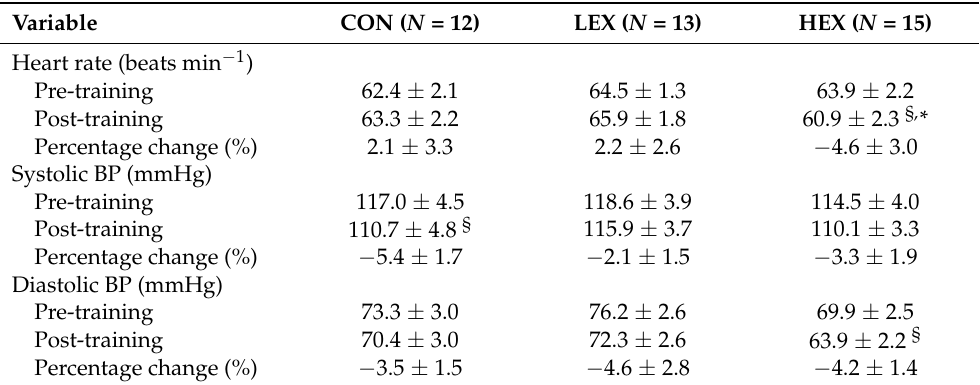
Table 4. Changes in supine hemodynamic measures for the CON, LEX, and HEX groups following 24 weeks of resistance training or a control